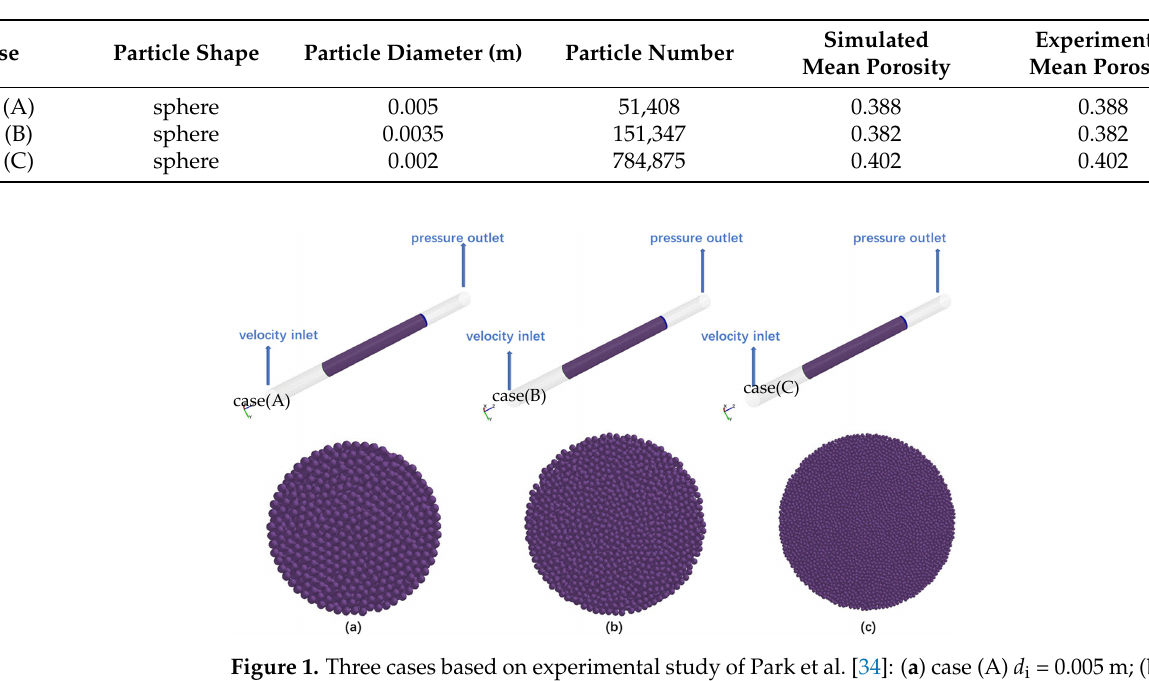
Table 1. Characteristics of case sphere particle beds.